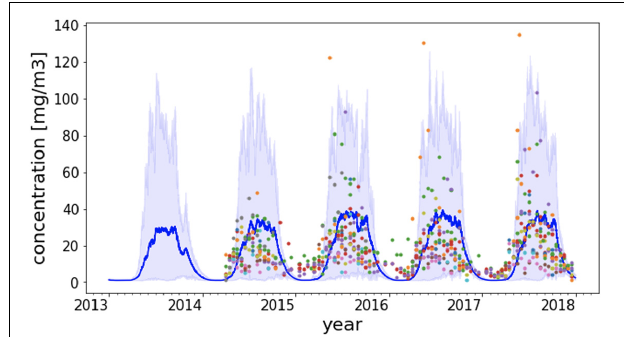
FIGURE 3 | Predicted time series of mesozooplankton biomass from 2014 to 2017 along with measured data from 16 monitoring stations in the Salish Sea. The dark blue line is the mean of predicted zooplankton values from model nodes corresponding to the station locations. The shaded region represents the 95th and 5th percentile range of predicted zooplankton at the station locations at each time step. A specific color of a data point is associated with a unique monitoring